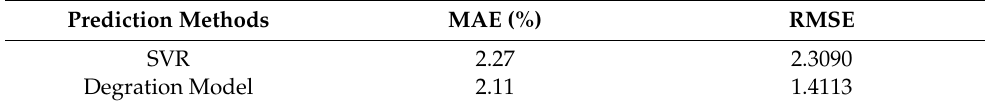
Table 3. Prediction error of the two